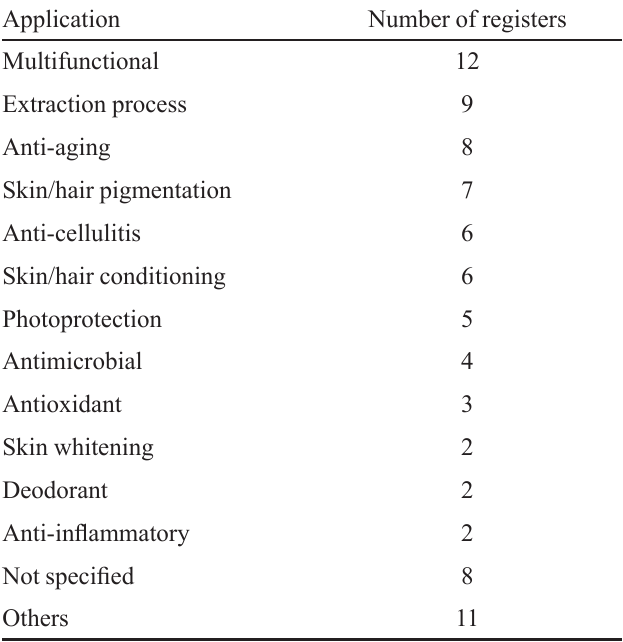
TABLE II - Cosmetic applications of plant extracts in INPI